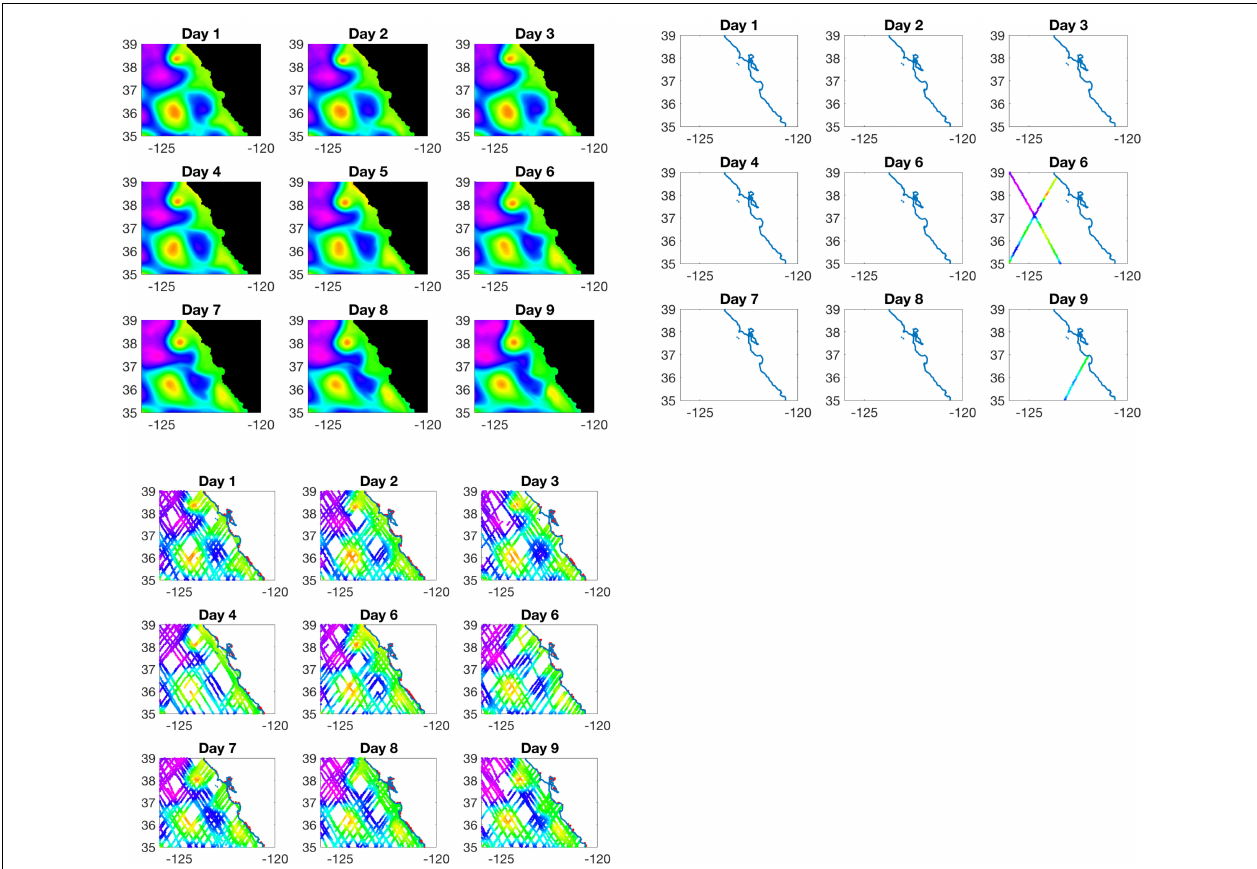
FIGURE 11 | The top left figure shows how the features of Monterey Bay changes spatially and temporally through a 9-day simulation. The top right figure shows sampling by traditional altimeters (Jason-3) of Monterey Bay area in 9-day period. The bottom left figure shows how the features of Monterey Bay can be sampled spatially and temporally using a constellation of eight receivers capable of capturing Ku-band reflected